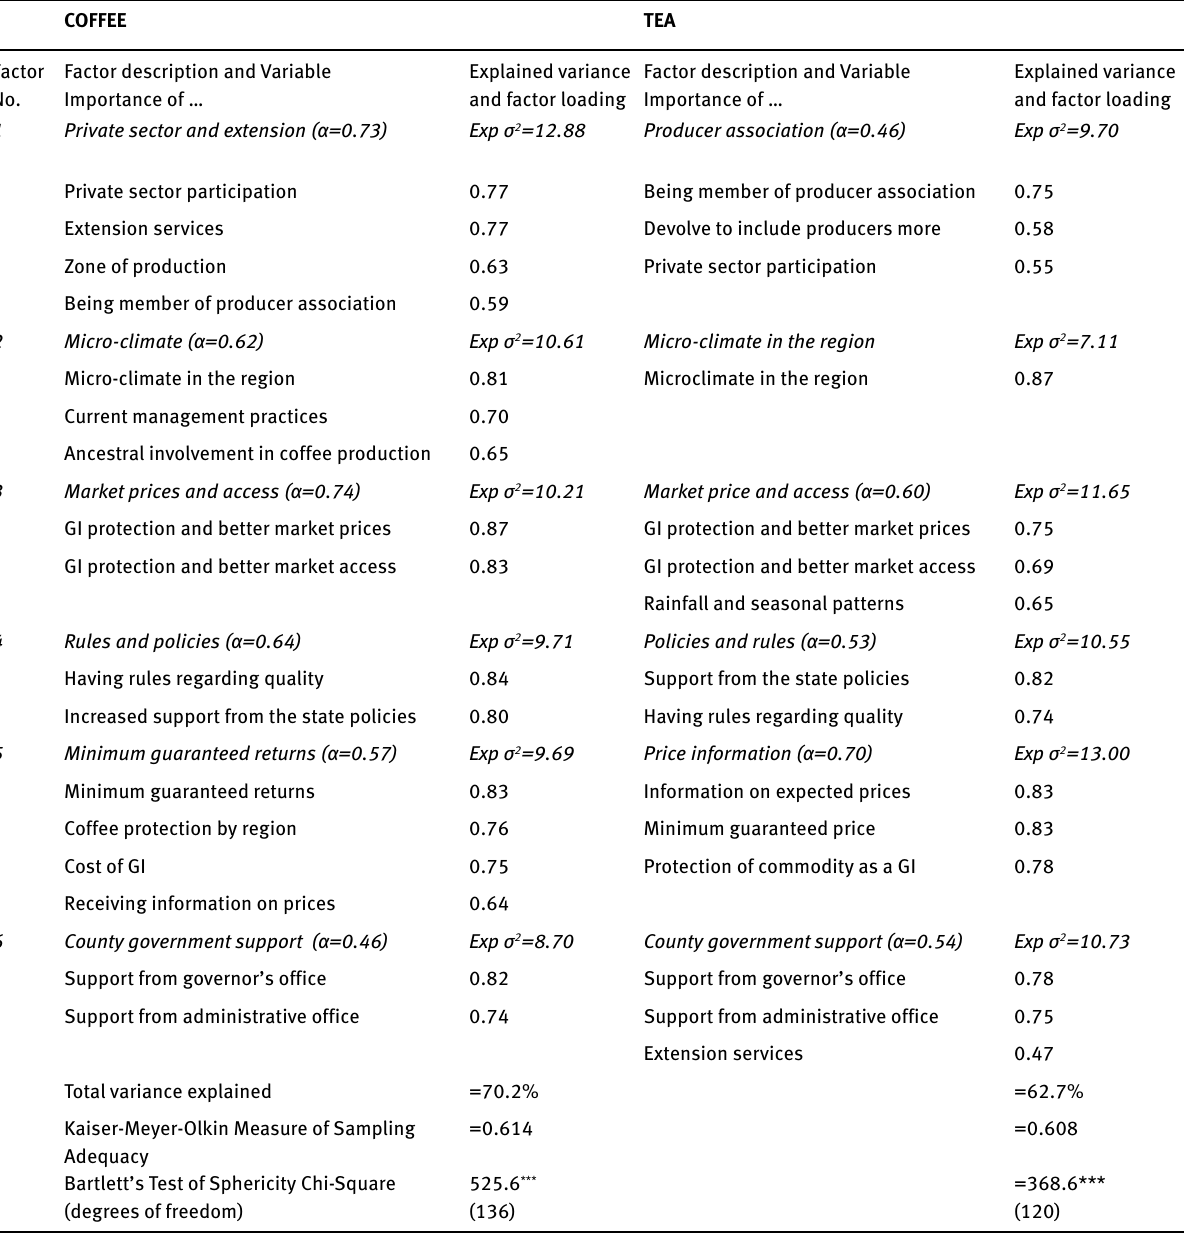
Table 2: Factor analysis of producer perceptions of coffee and tea as potential GI export beverage crops